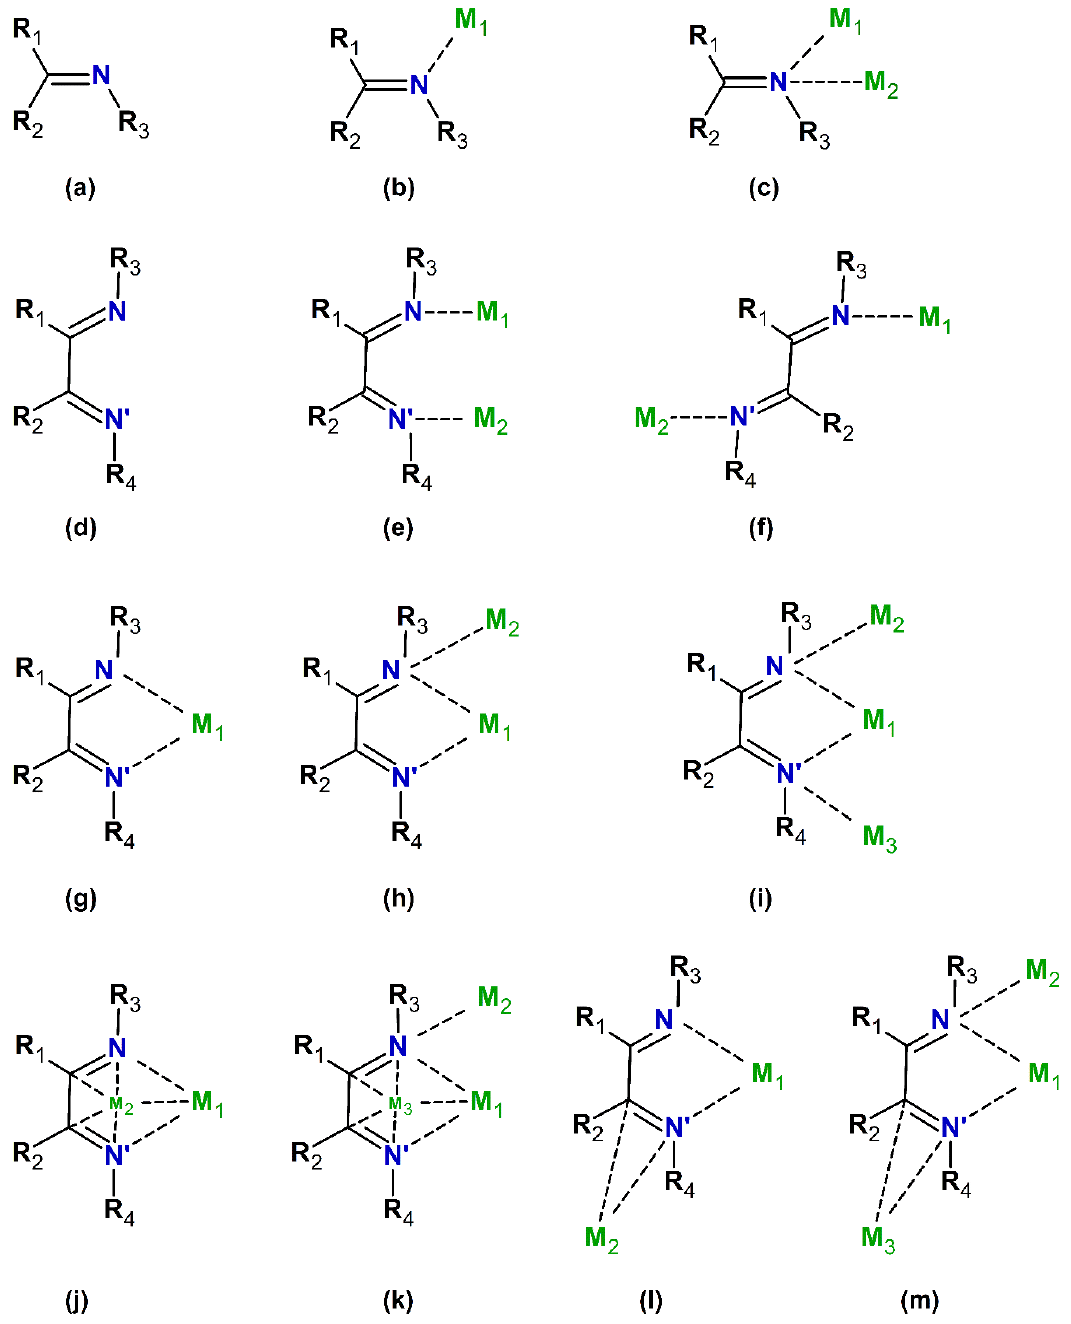
Scheme 1. Coordination modes of imine and 1,2-diimine ligands with denticity of ligands described